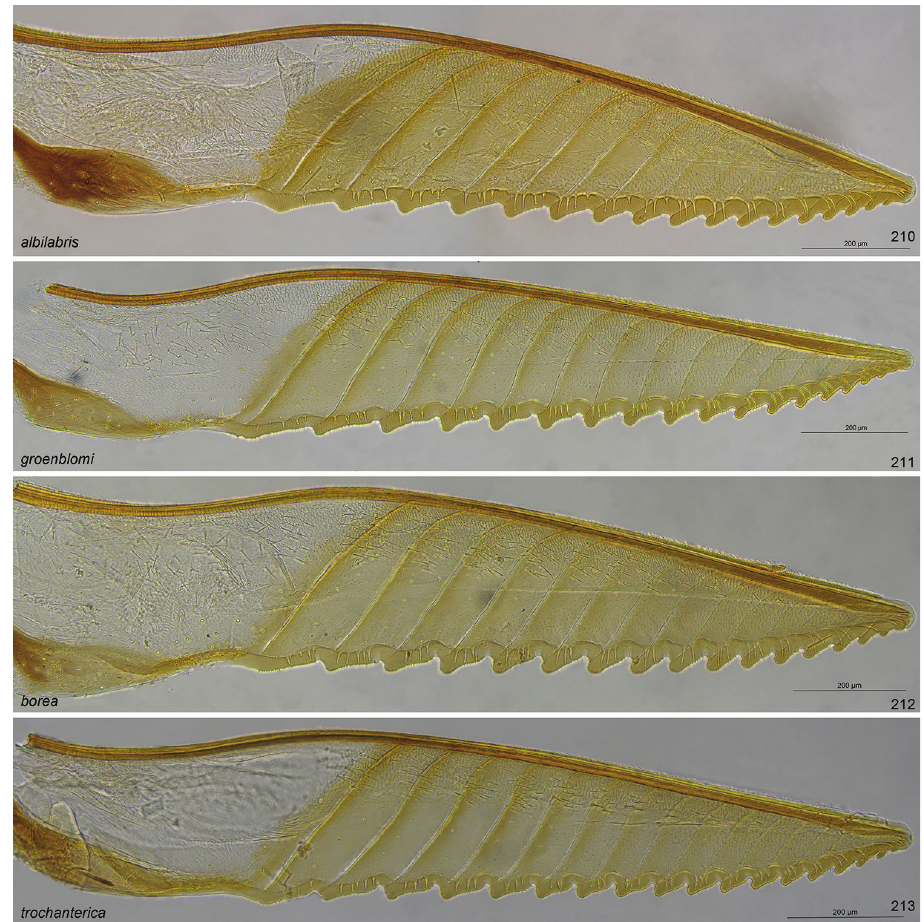
Figures 210–213. Lancets of Pristiphora . 210 albilabris DEI-GISHym20943 211 groenblomi DEI- GISHym31597 212 borea DEI-GISHym31609 213 trochanterica